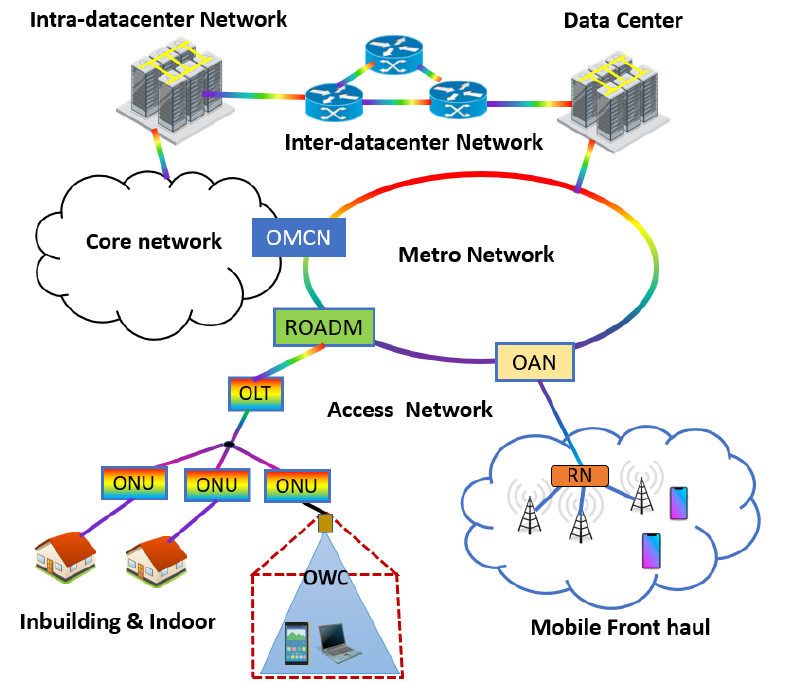
Figure 1. Short-reach optical communication system. OMCN: optical metro-core node, OAN: optical aggregation node, ROADM: reconfigurable optical add-drop node, ONU: optical network unit, RN: remote node, OLT: optical line termination, OWC: optical wireless